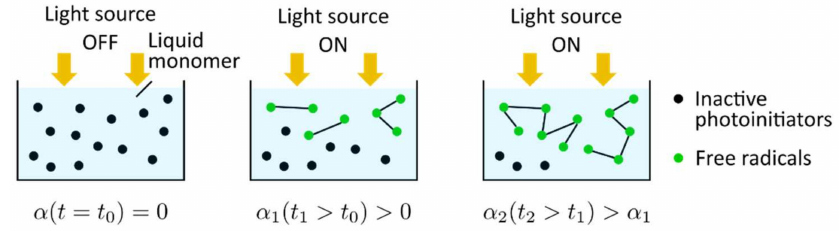
Figure 14. General photopolymerization